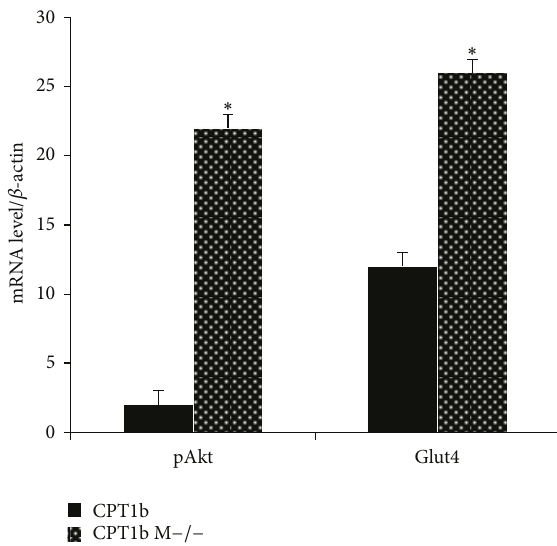
Figure 4: RT-PCR for pAkt and Glut4 showed preserved expression with CTP1b specific knockout. 𝑛 = 20 for each group. ∗ 𝑃 < 0.05